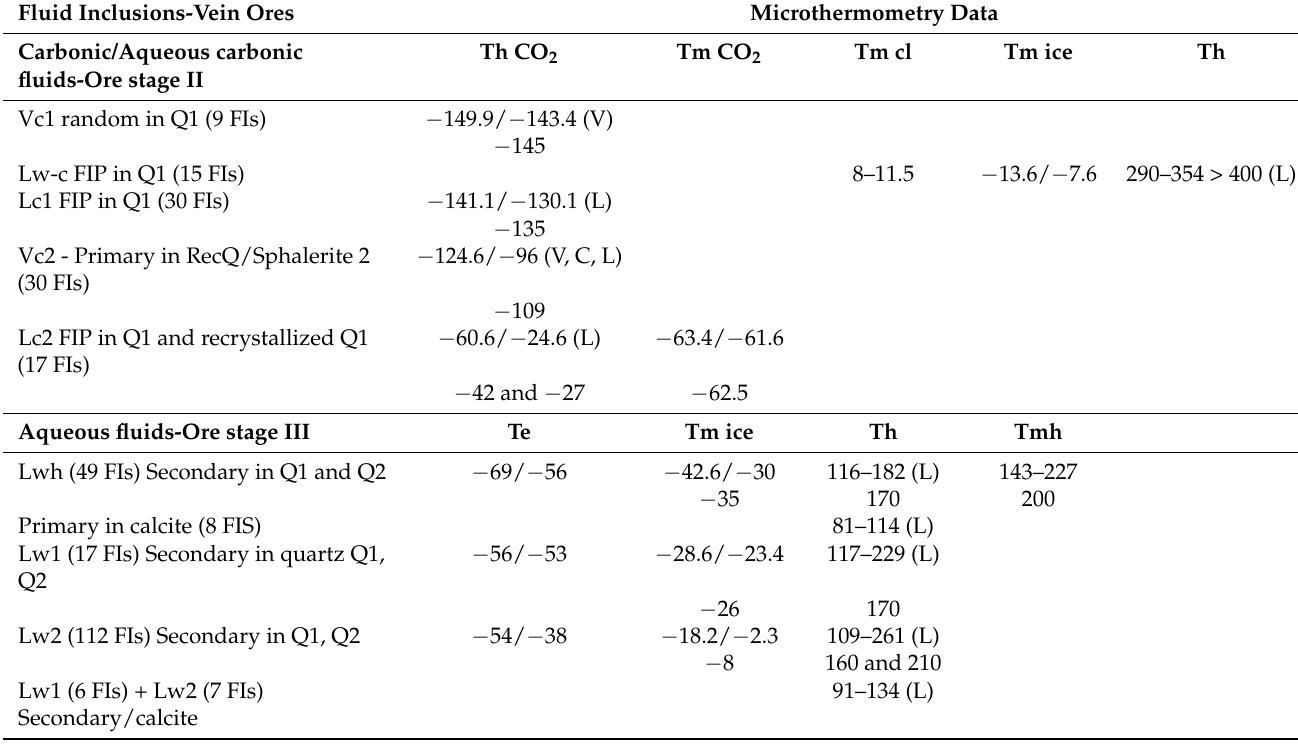
Table 4. Summary of microthermometric data of fluid inclusions from veins (vein stages II and III) at the Koudiat Aïcha deposit. Tm CO 2 : melting temperature of the volatile phase; Th CO 2 : homogenization temperature of the volatile phase to the liquid (L), vapor (V) or critical (C) phases; Tm cl: melting temperature of clathrate; Te: eutectic temperature; Tm ice: melting temperature of ice; Th: homogenization temperature to the liquid (L) phase; Tm h: melting temperature of